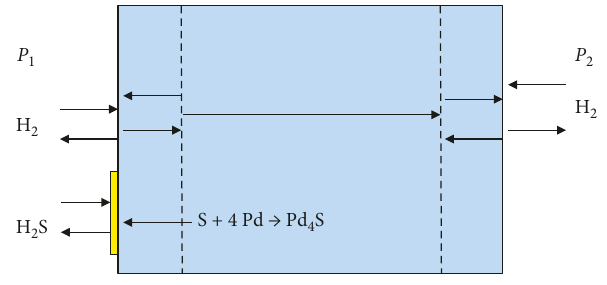
Figure 4: Schematic of the poisoning